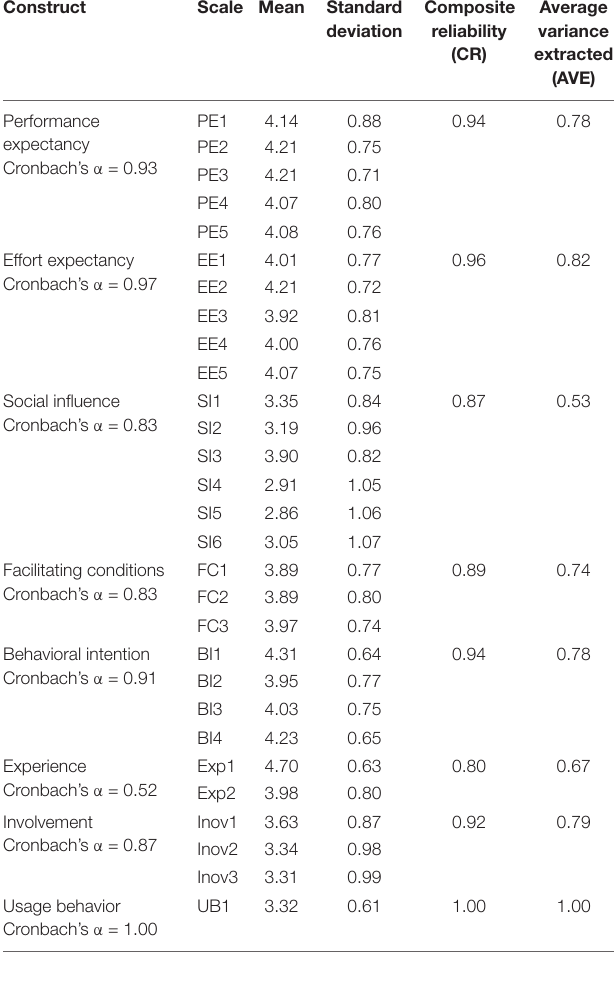
TABLE 1 | Reliability and convergent validity.